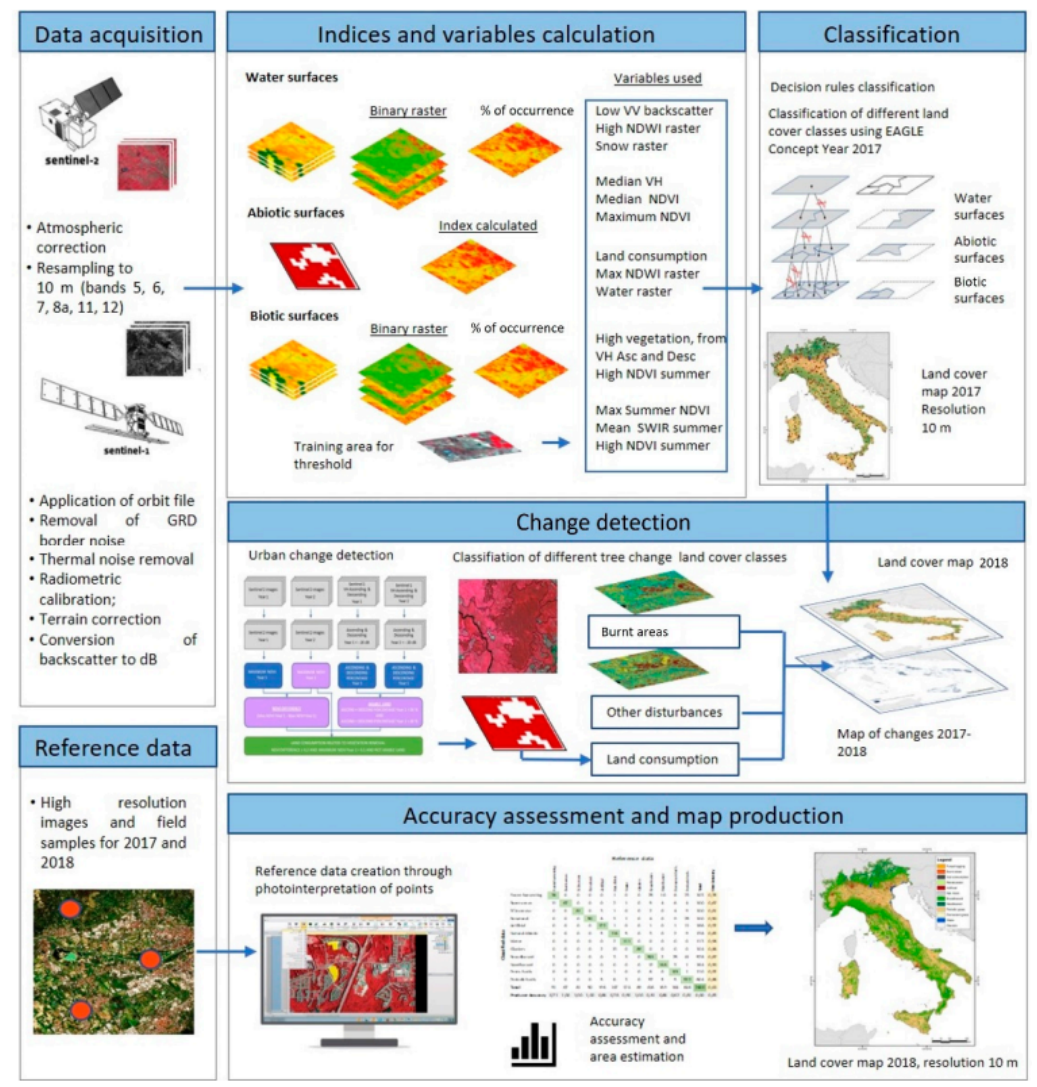
Figure 1. Workflow of the